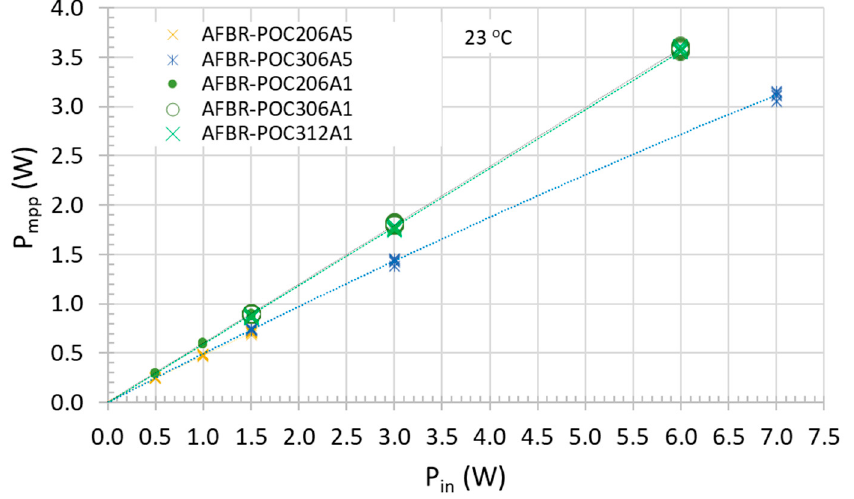
Figure 3. OPCs’ output power vs. optical input power curves for the regular ‐ power (AFBR ‐ POC206A1 and AFBR ‐ POC206A5) and medium ‐ power (AFBR ‐ POC306A1, AFBR ‐ POC312A1, and AFBR ‐ POC306A5). The “A1” and “A5” devices are designed for, and measured at, an optical input wavelength of ~808 nm and ~975 nm respectively.